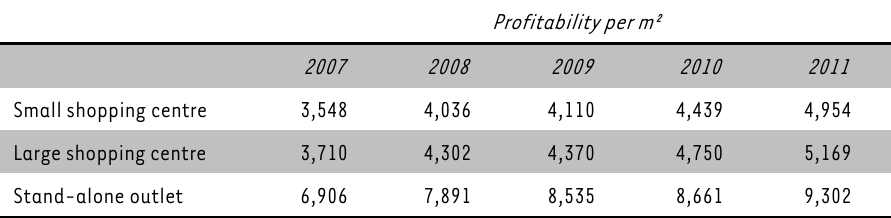
TABLE 11: Profitability per m² by retail format type